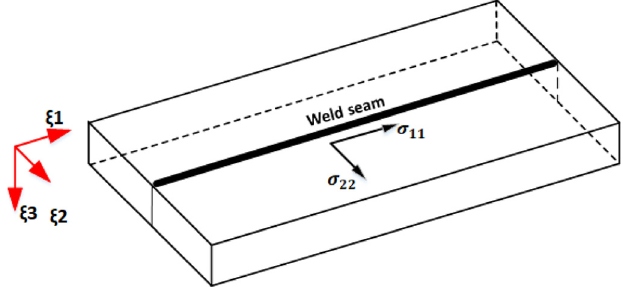
Fig. 1. Schematic diagram showing welding of two